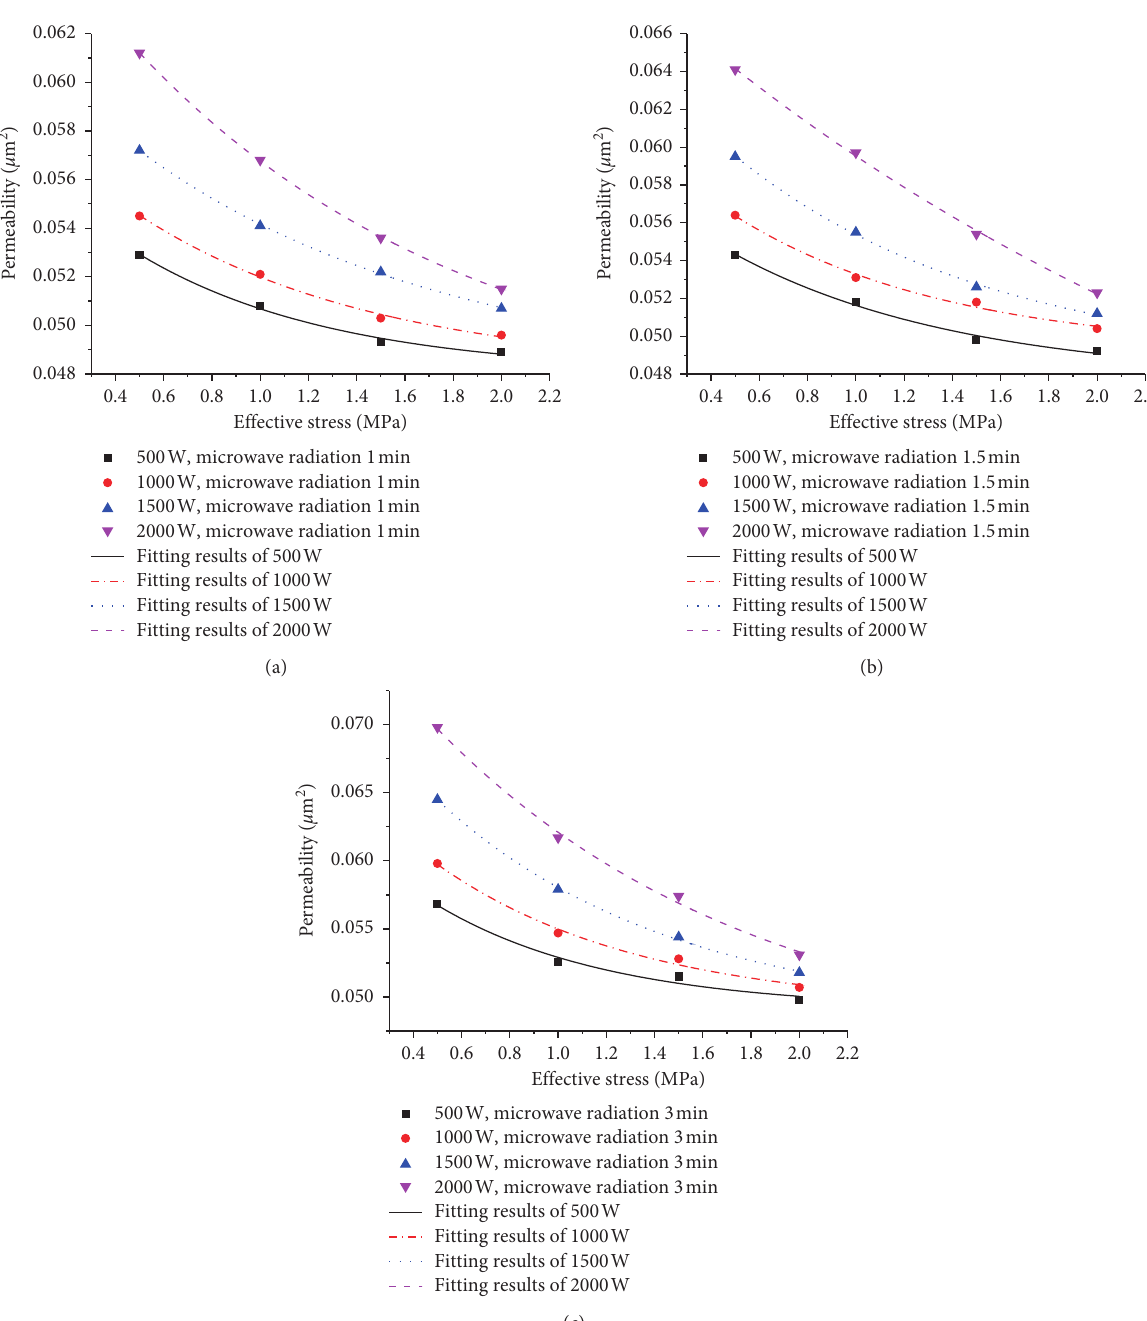
Figure 6: Effect of microwave power on permeability at a confining pressure of 5